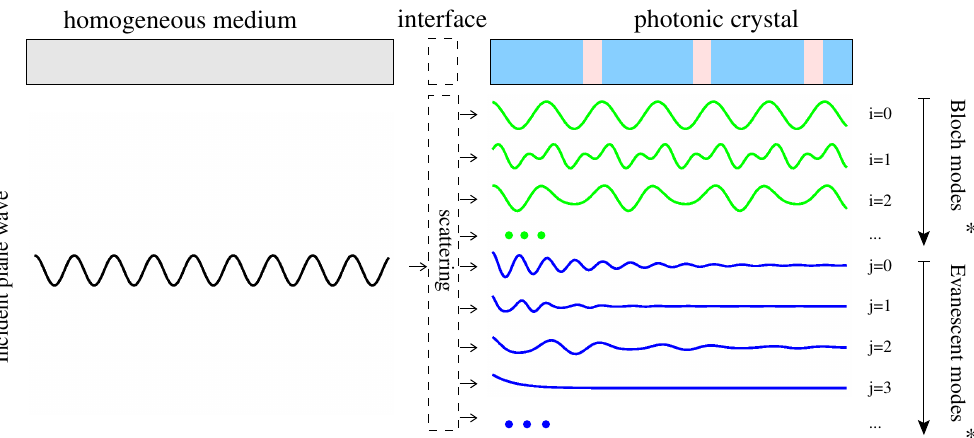
Figure 2. Mock-illustration of the scattering process of a plane wave incident onto a slab of photonic crystal: both conventional dispersive Bloch modes (labelled i ) and evanescent modes (whose amplitude decays away from the interface labelled j ) need to be taken into account when evaluating the reflectance and transmission properties. (*) Note that the display of both the Bloch modes and of the evanescent modes excludes the (aperiodic) phase factor exp p ıkr q